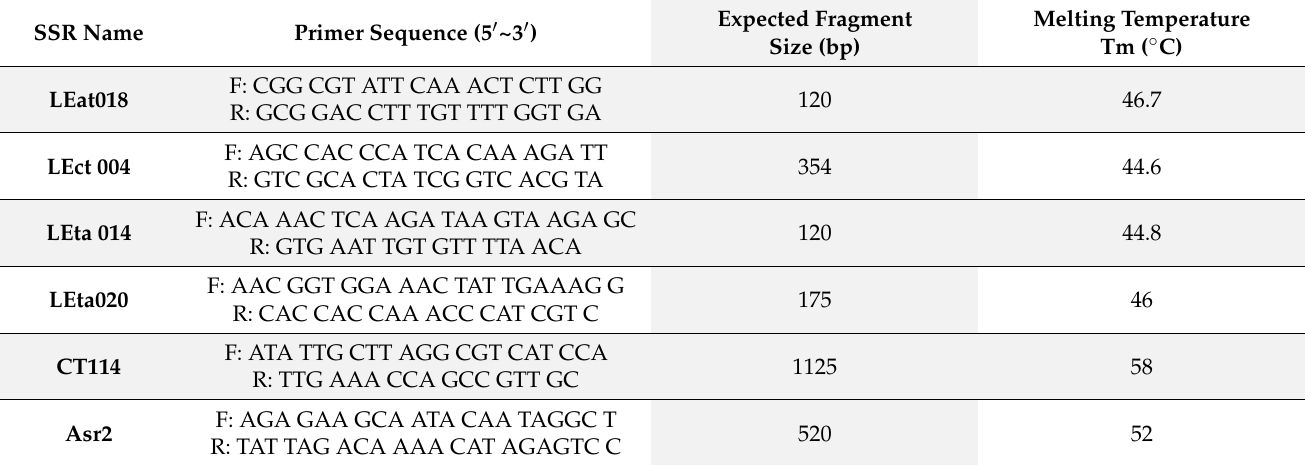
Table 2. Primers and their sequence, expected fragment, and melting